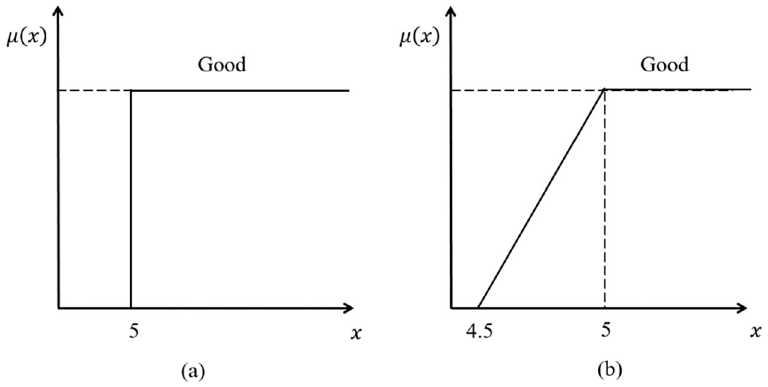
Figure 2. Different representations of “good”. ( a ) Classical set ( b ) Fuzzy set